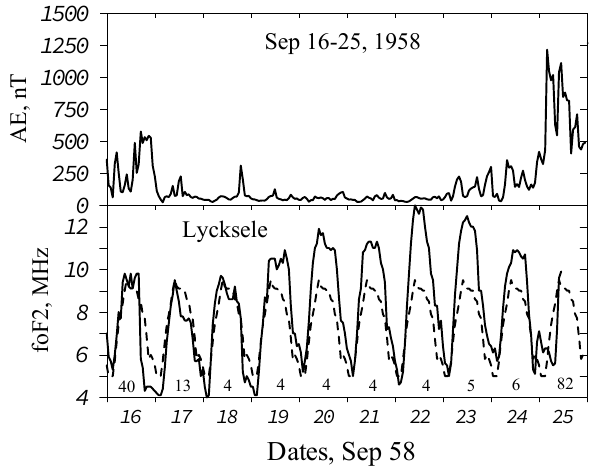
Fig. 6. Fig. 6. Observed variations of AE-index and fo F2 at Lycksele dur- ing the 16–25 September 1958 period. Note a continuous increase of fo F2 daytime values until September 22 as a result of the mag- netic tube of force refilling by plasma from the daytime F2-region. Figures in the bottom panel – daily A p indices. Dashes – median fo F2